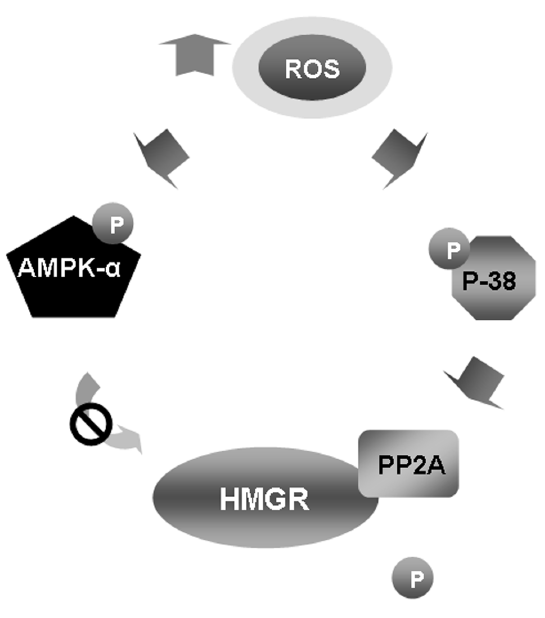
FIGURE 2. Proposed model of ROS-induced HMGR full activation state. The figure shows the proposed mechanism operated by ROS in inducing hepatic HMGR dephosphorylation. ROS increase is able to activate both AMPK α and p38, which in turn triggers the PP2A phosphorylating activity on HMGR, thereby activating it. PP2A action thus impairs AMPK α phosphorylating action on